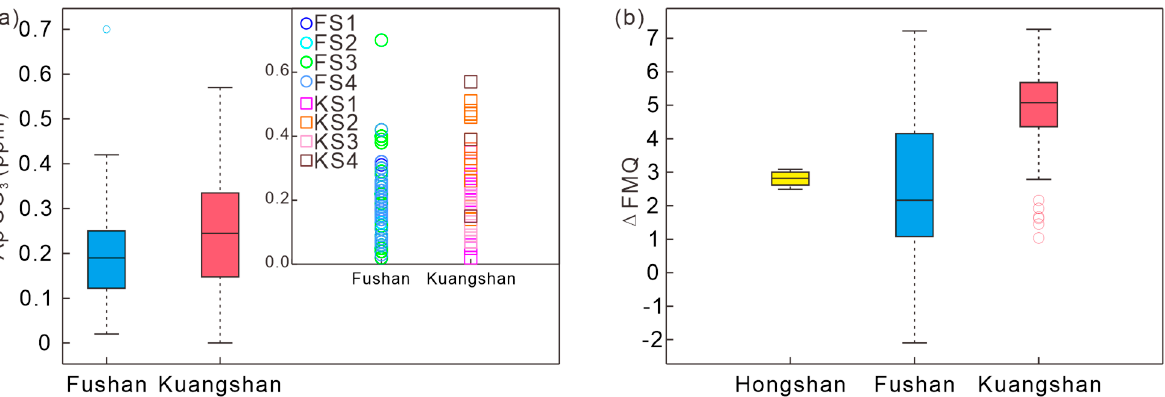
Figure 10. ( a ) Diagrams of SO 3 content in apatite (Fushan complex: FS1—Porphyritic hornblende diorite, FS2—Hornblende diorite, FS3—Diorite, FS4—Monzonite; Kuangshan complex: